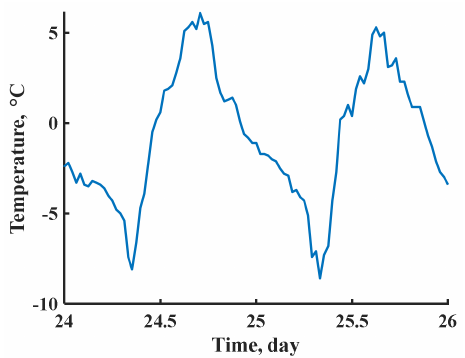
Figure 7. External temperature during 2